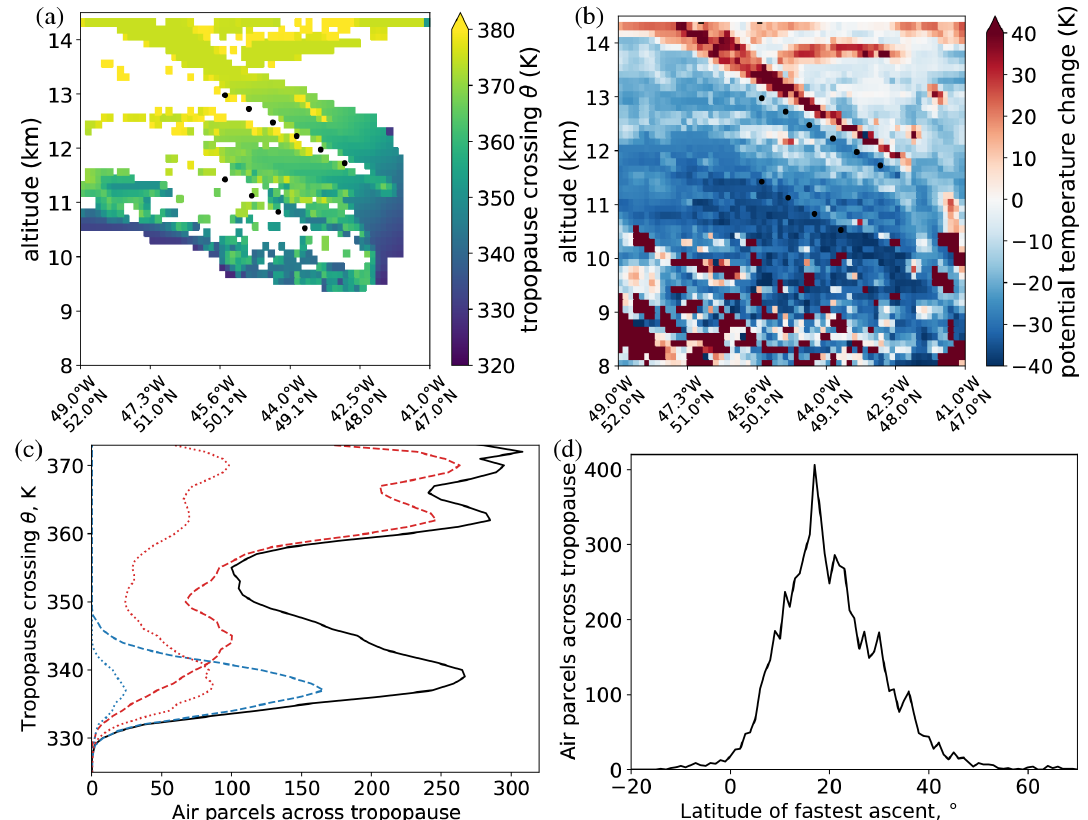
Figure 10. Panel (a) shows the potential temperature of tropopause crossing for the parcels that crossed tropopause within the last month. Panel (b) shows the change in potential temperature of observed air parcels within the last month. Black circles in panels (a) and (b) mark retrieved old air filaments; they are at the same positions as the white circles in Fig. 7. Panel (c) shows the distribution of potential temperature of tropopause crossing for the observed air parcels (black line). Other lines show how many of these parcels have been to TTL within last 30d (dashed red line), extratropics below 330K potential temperature within the last 30d (dashed blue line), PBL within the last 60d (dotted red line) and PBL within the last 60d but not TTL (dotted blue line). All lines show the 5K running mean. Panel (d) shows the latitude of fastest ascent (over 1d) in potential temperature for the parcels shown in panel (c)